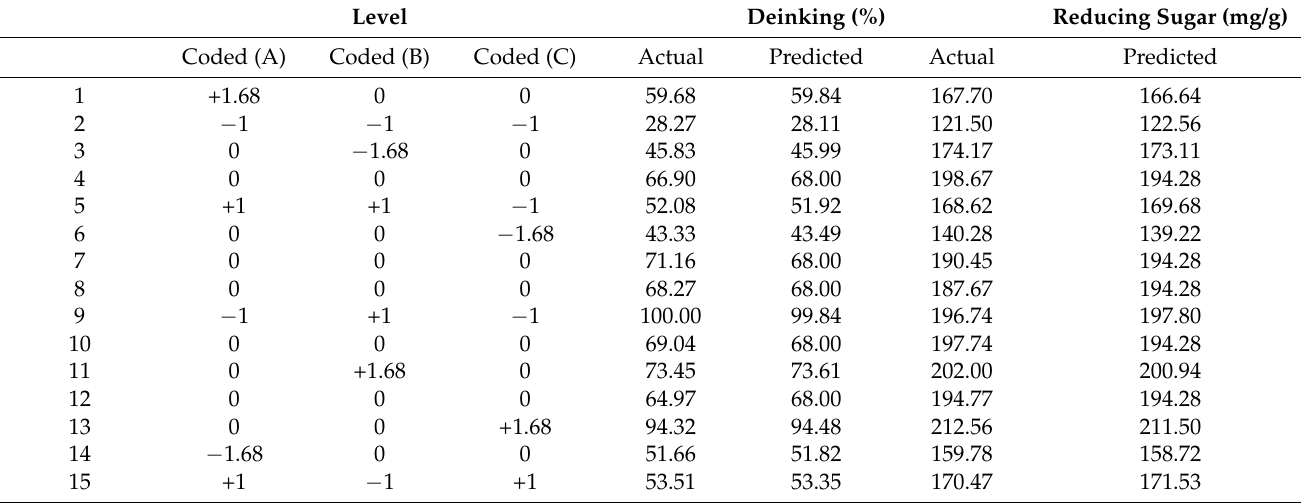
Table 7. Central composite design for the optimization of Beauveria bassiana SAN01 xylanase-assisted printed paper deinking and the response of the dependent